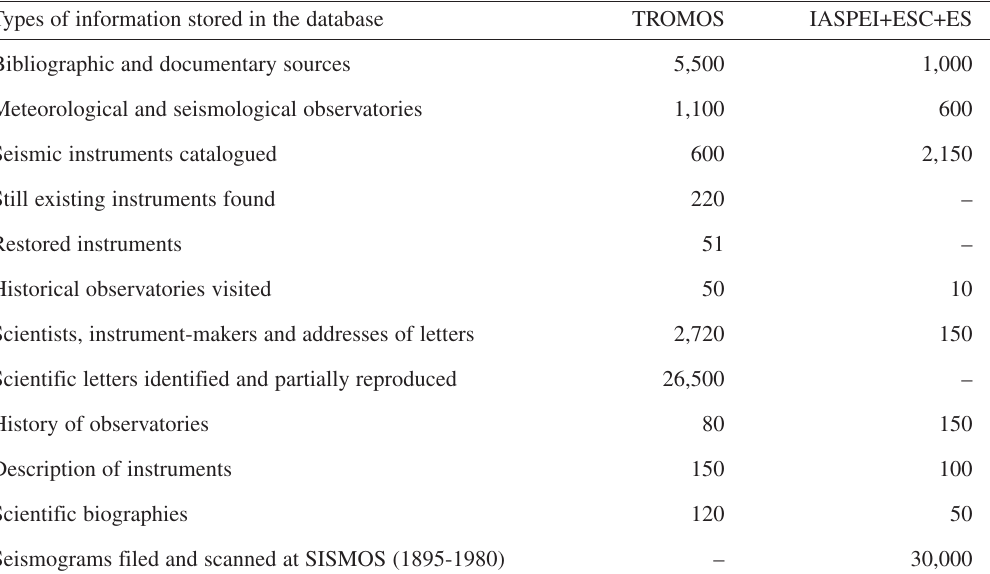
Table I. Quantitative results of both the Italian TROMOS Project and the worldwide IASPEI, ESC and ES proj- ects in the period 1990-2007. Values are approximated and some for the IASPEI, ESC projects not evaluable. Types of information stored in the